Question: Name the type of graph shown.
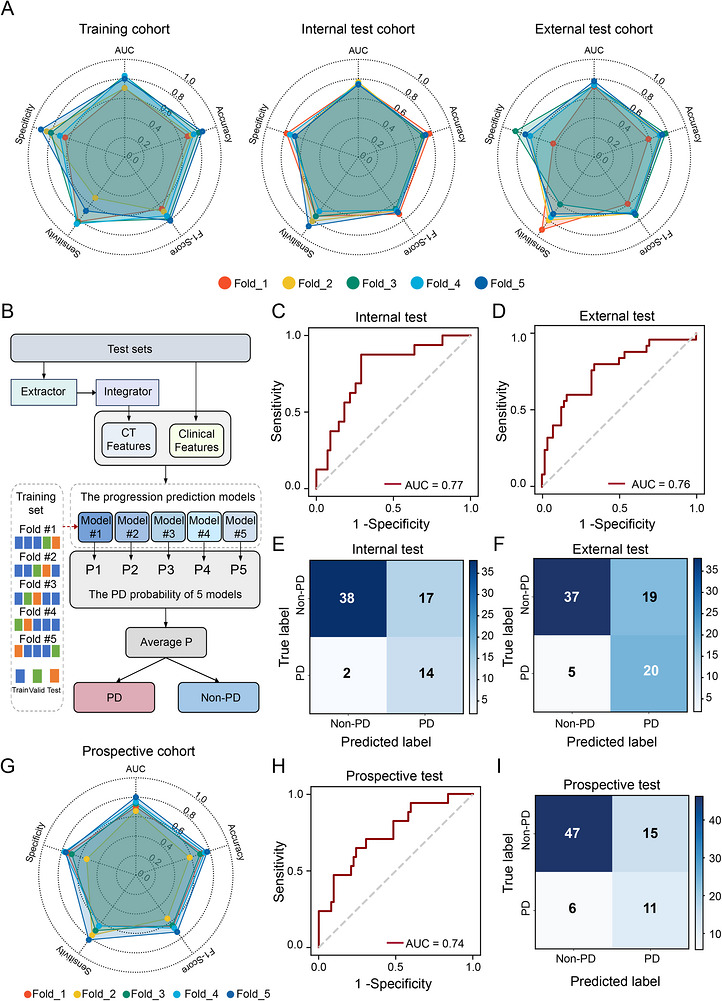
Answer: heatmap